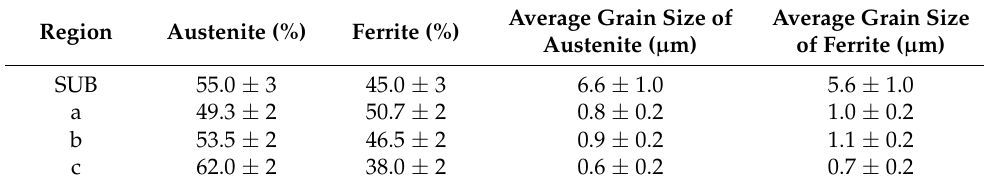
Table 3. Volume fraction of austenite and ferrite in different regions.